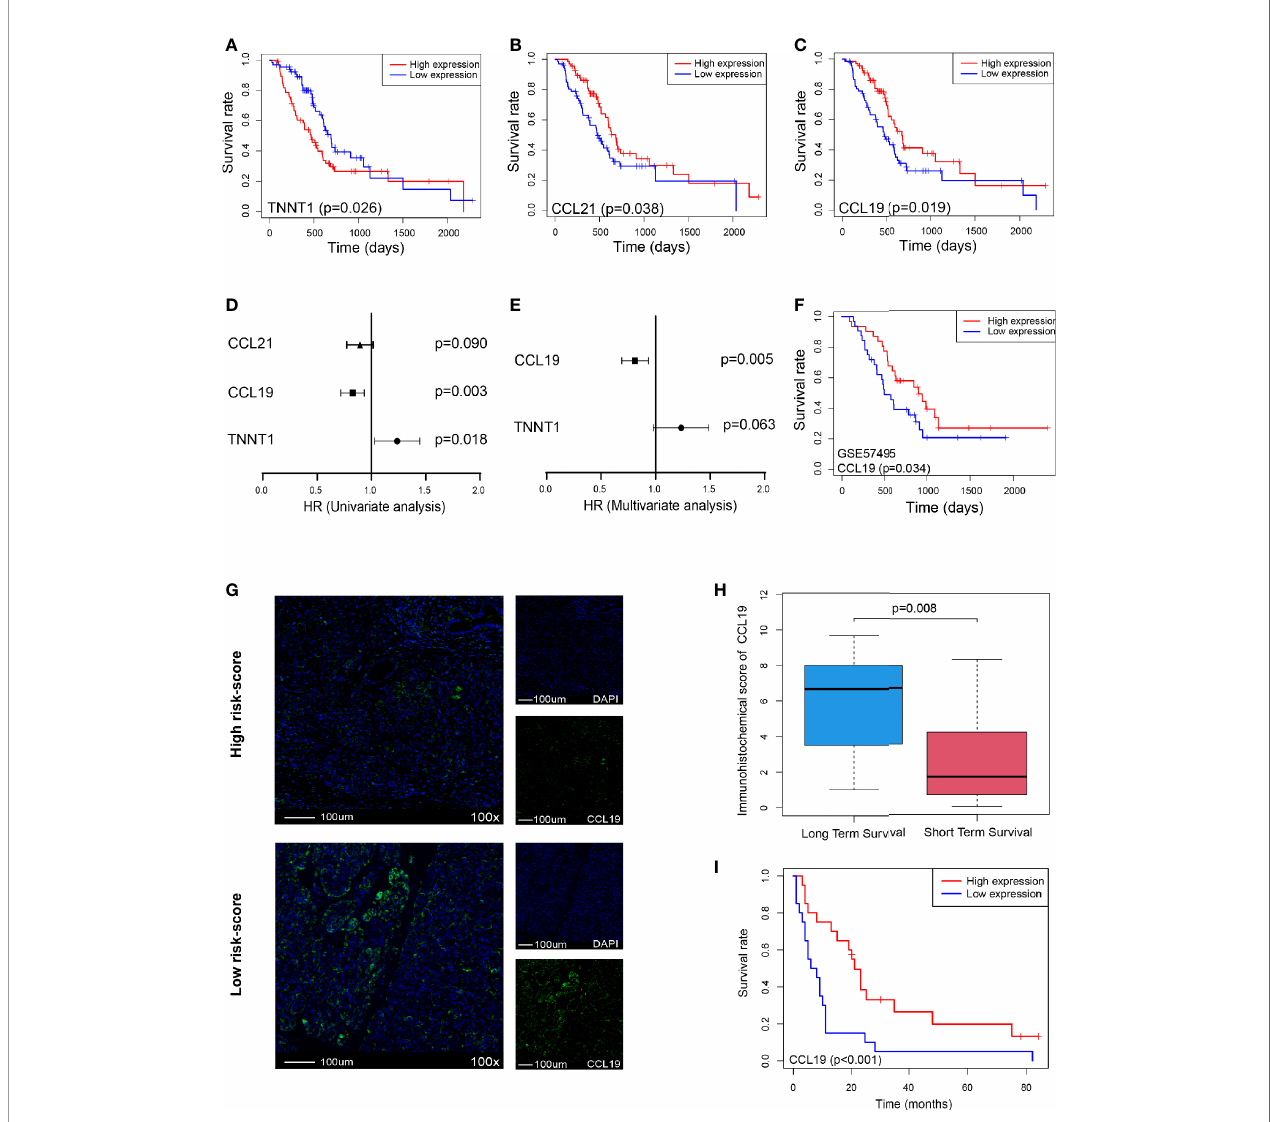
FIGURE 7 | CCL19 is a potential factor affecting risk score. (A – C) OS in TNNT1, CCL21, and CCL19 high- vs . low-expression patients depicted by KM plots in TCGA PDAC discovery cohort, respectively. (D, E) Forest plot showing the HR of TNNT1, CCL21, and CCL19 in the univariate and multivariate Cox analyses, respectively, in TCGA PDAC discovery cohort. (F) OS in CCL19 high- vs . low-expression patients depicted by KM plots in GSE57495 validation cohort. (G) Multiplex immuno fl uorescence analyses on CCL19 expression in Peking2020 cohort (n = 40, randomly select three fi elds at least). (H) Box plot depicts CCL19 expression between long-term survival and short-term survival in Peking2020 cohort. (I) OS in CCL19 high- vs . low-expression patients depicted by KM plots in Peking2020 cohort. OS, overall survival; KM, Kaplan – Meier; HR, hazard ratios; TCGA, The Cancer Genome Atlas; PDAC, pancreatic ductal